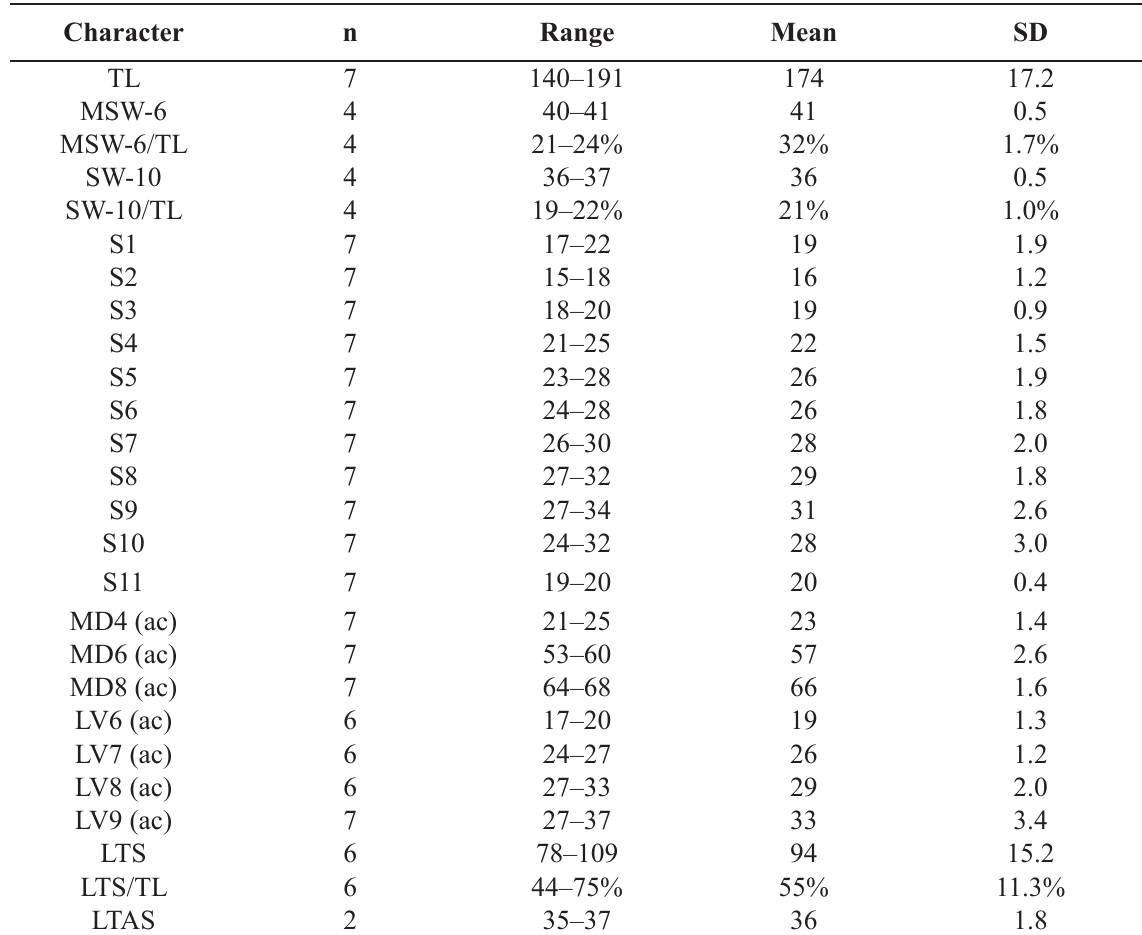
Table 14. Measurements from light microscopy of Echinoderes samwisei sp. nov . (in µm) from the Hikurangi Margin, including number of measured specimens (n) and standard deviation